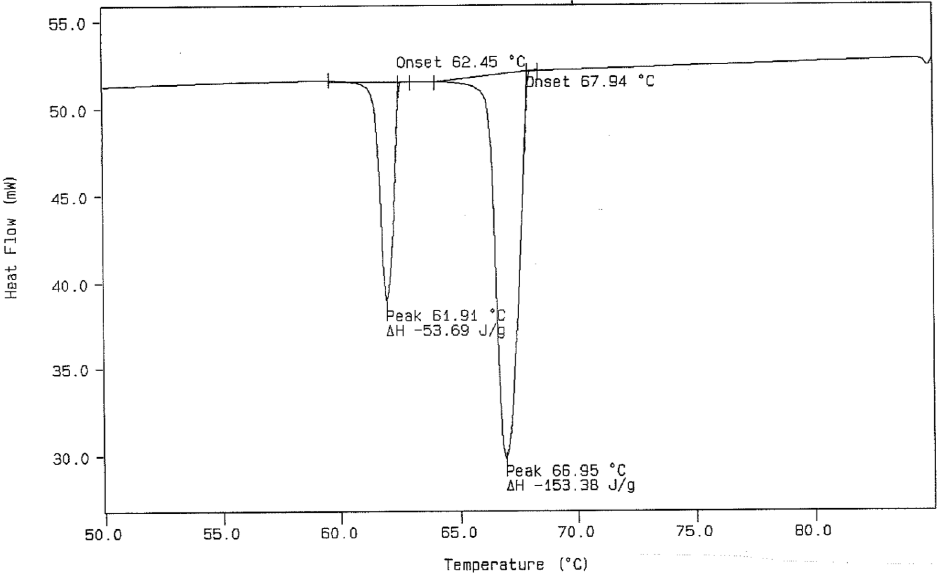
Figure 5. DSC Cooling Curve from Figure 4 with Calculations of Onset Temperature (°C) and Heat of Transitions (Joules/gram).